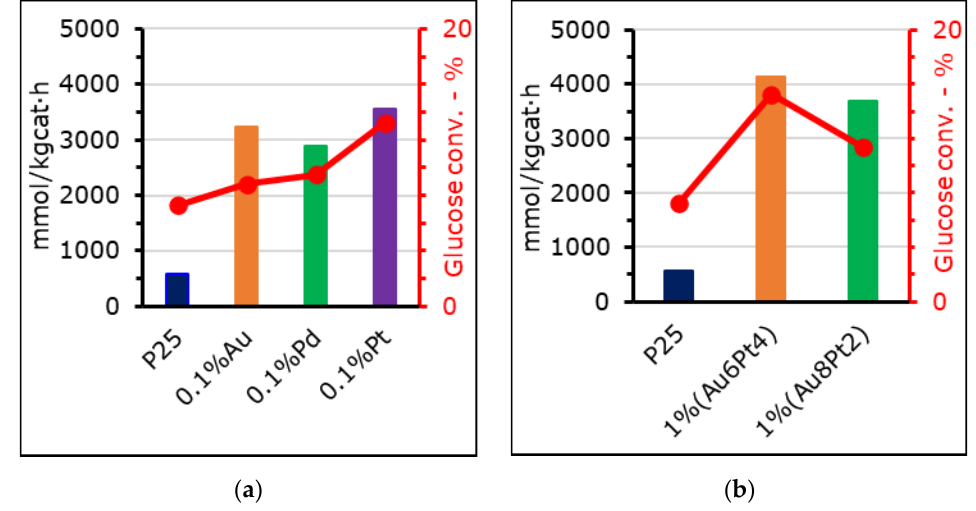
Figure 7. Hydrogen productivities through glucose photo − reforming achieved with 0.250 g/L of photo-catalyst, 5 g/L of glucose at pH = 6.5, 4 h test with medium pressure UV lamp. ( a ) mono- metallic and ( b ) bi-metallic photo-catalysts. Table 6. Performance in the glucose photo-reforming of different photo-catalysts reported in literature.